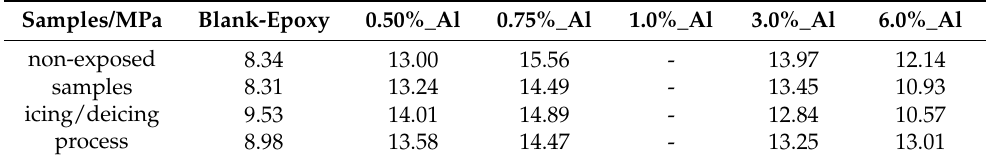
Table 5. Adhesion test results for epoxy matrix with and without adding Al NPs as well as before and after the icing/deicing